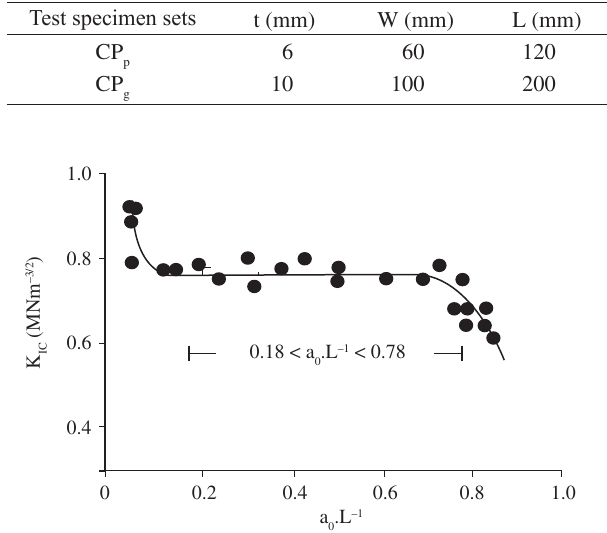
Figure 1. K measured in toluene for sodium-lime-silica glass as a function IC of the a .L –1 ratio in double-torsion tests 17 0